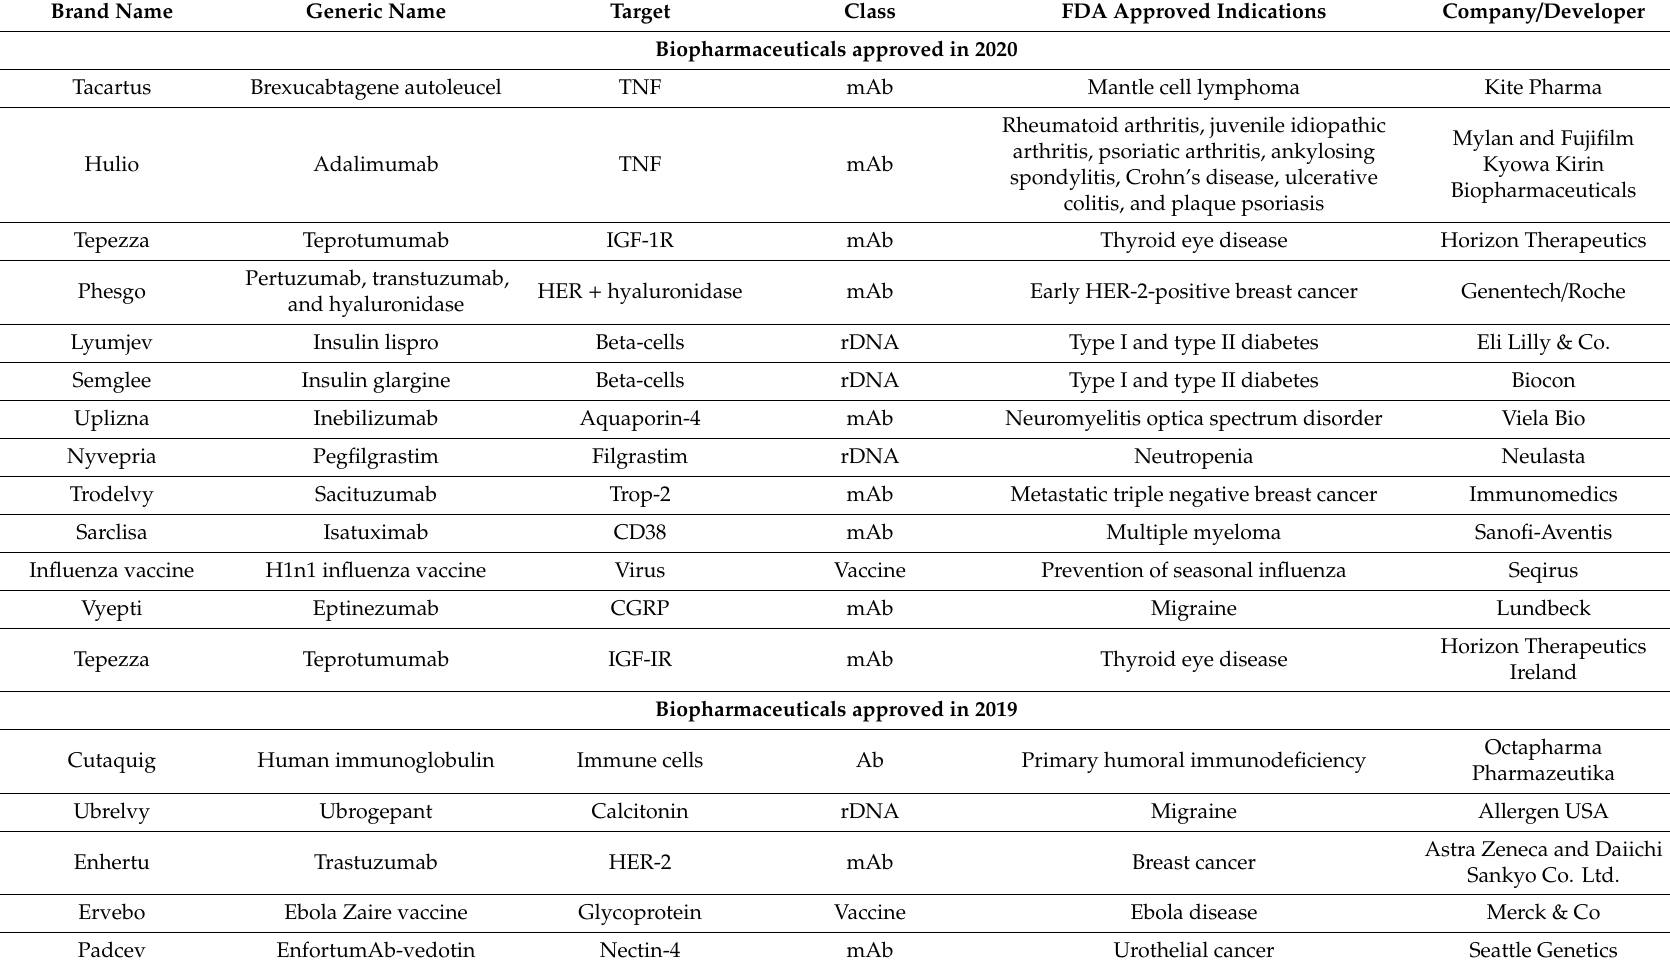
Table 1. Biopharmaceuticals and their clinical indications approved by the FDA in 2018–2020